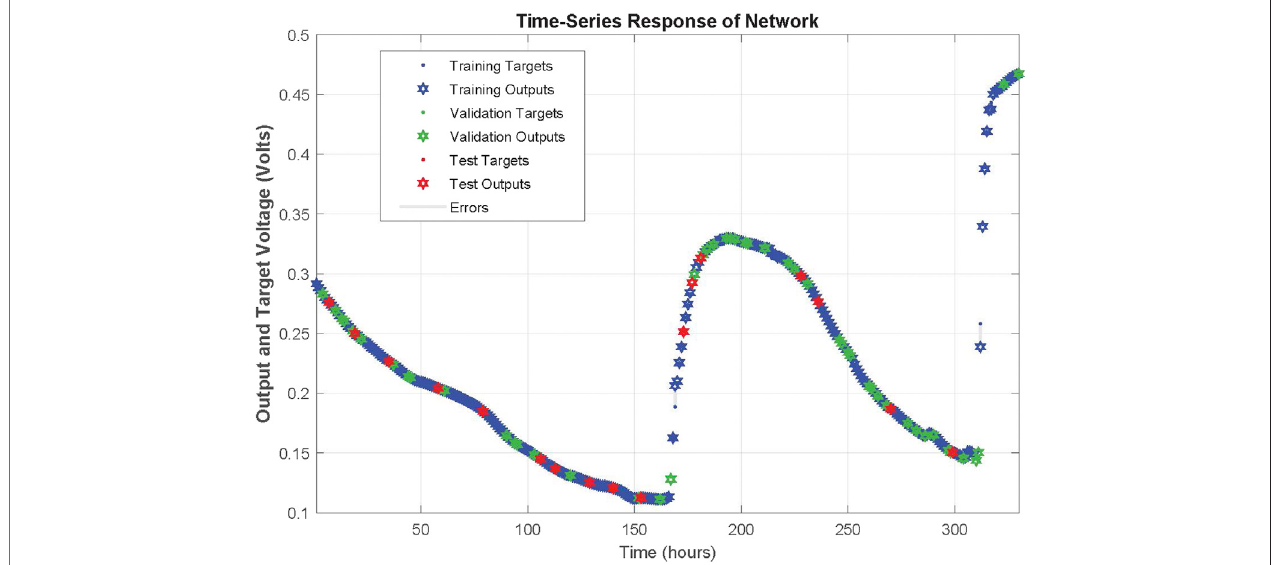
FIGURE 5 | Response of NARX on training, validation and testing dataset time-series of fi rst MFC.